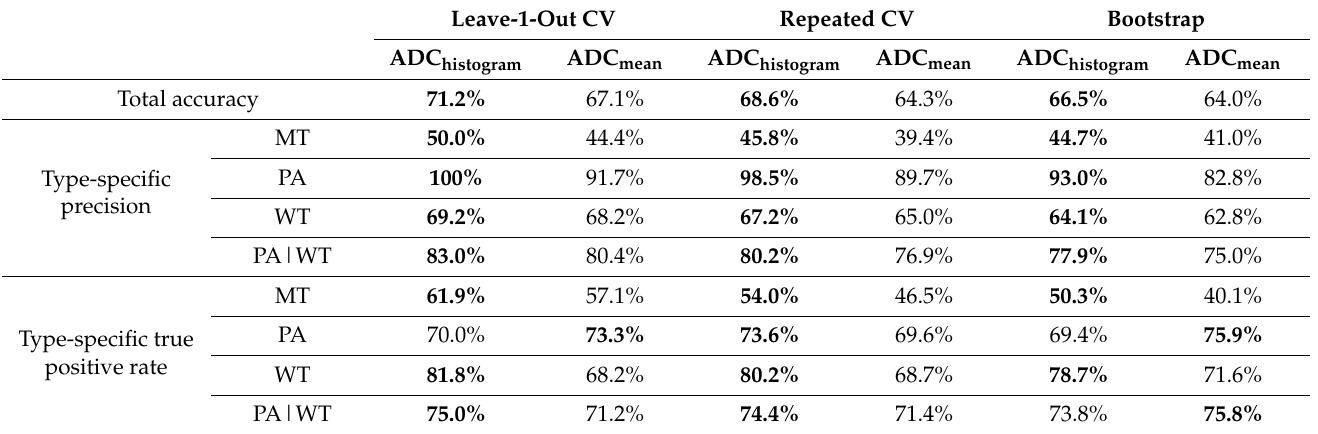
Table 4. Cross-validation results with total accuracy giving the overall proportion of correct clas- sifications as well as type-specific precision, i.e., the proportion of true positives from the set of corresponding predictions, and true positive rate, i.e., the proportion of true positives given the corresponding true types (bold numbers indicate superior performance). Leave-1-Out CV Repeated CV Bootstrap ADC histogram ADC mean ADC histogram ADC mean ADC histogram ADC mean Total accuracy 71.2% 67.1% 68.6% 64.3% 66.5%